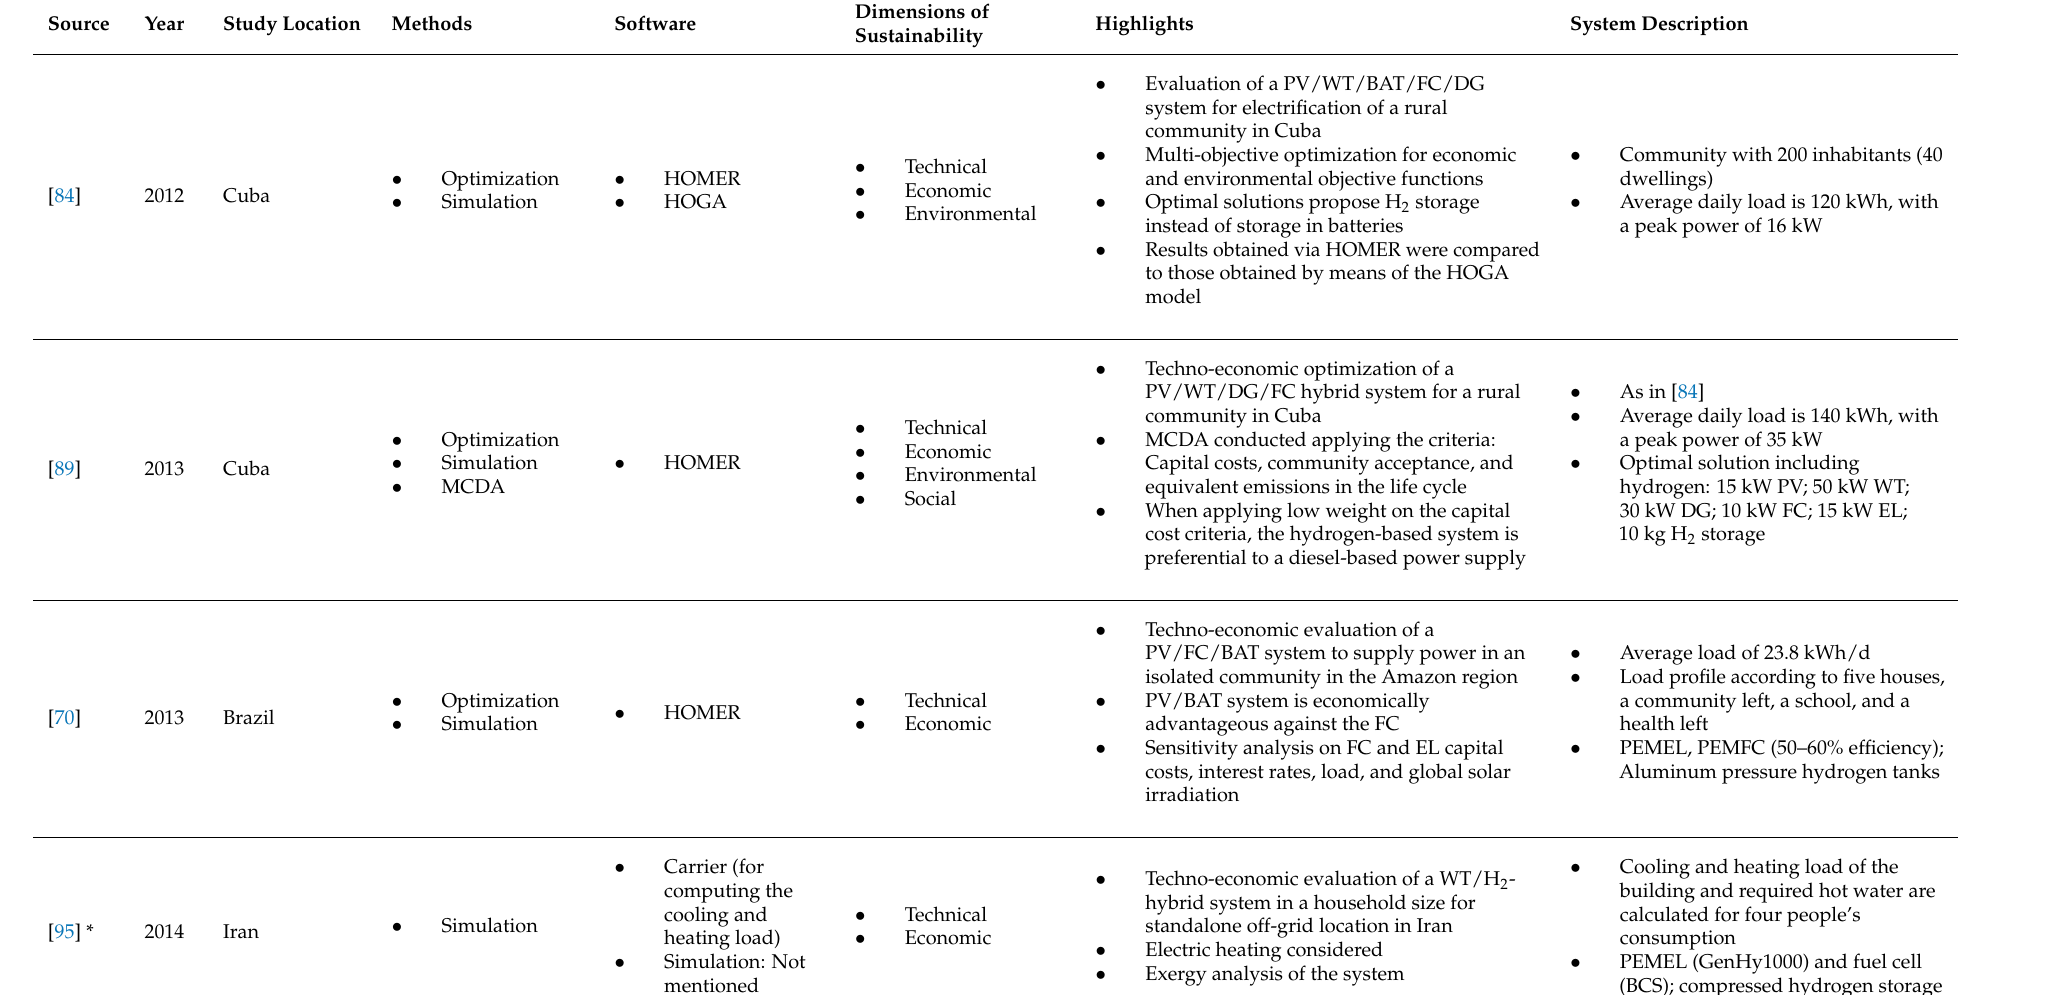
Table 5. Variables of interest for the literature considering hydrogen applications for off-grid power supply to lower electrical appliances and electric